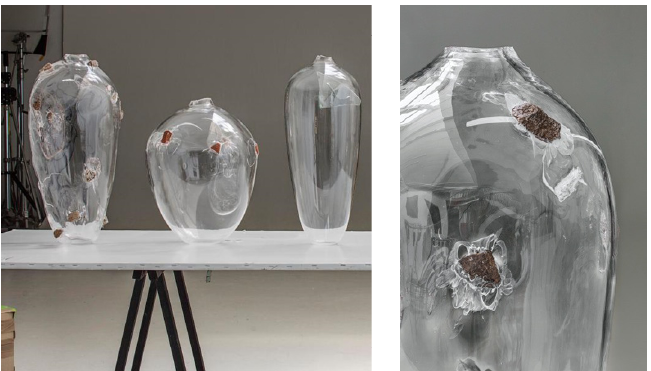
Figure 4. Maria Bang Espersen, “Things Change”, glass, brick, window glass and rock, 2015 approximately 53 cm × 30 cm × 25 cm each, photo credit: courtesy of the artist, used with permission.